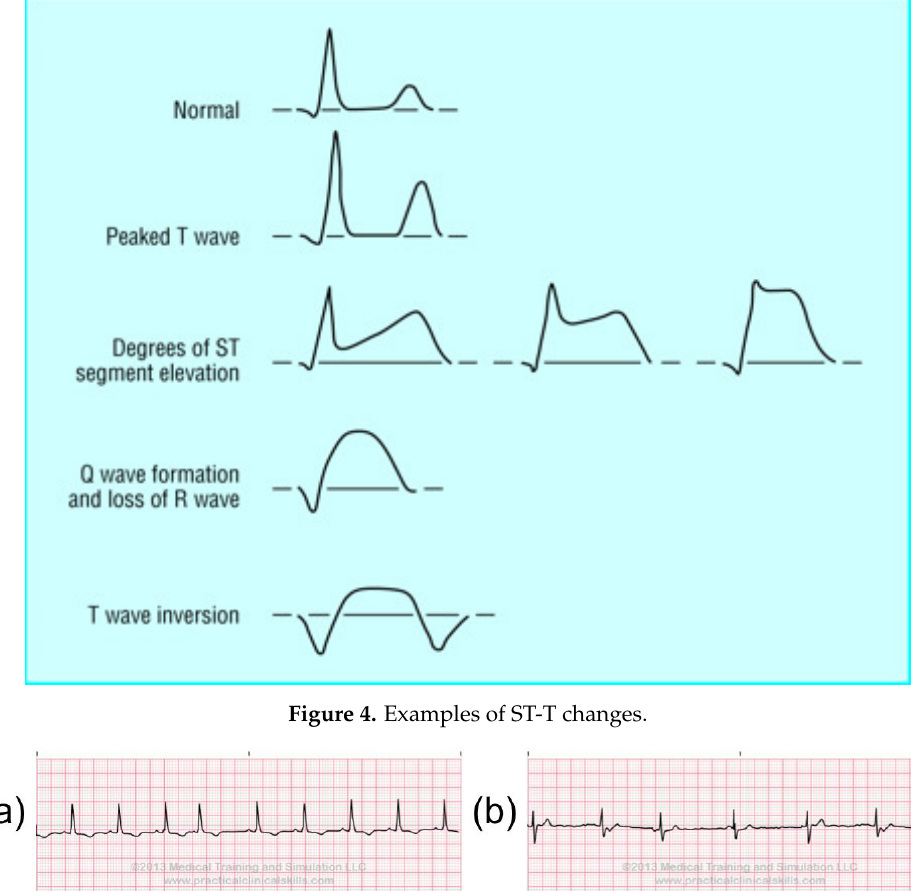
Figure 4. Examples of ST-T changes.